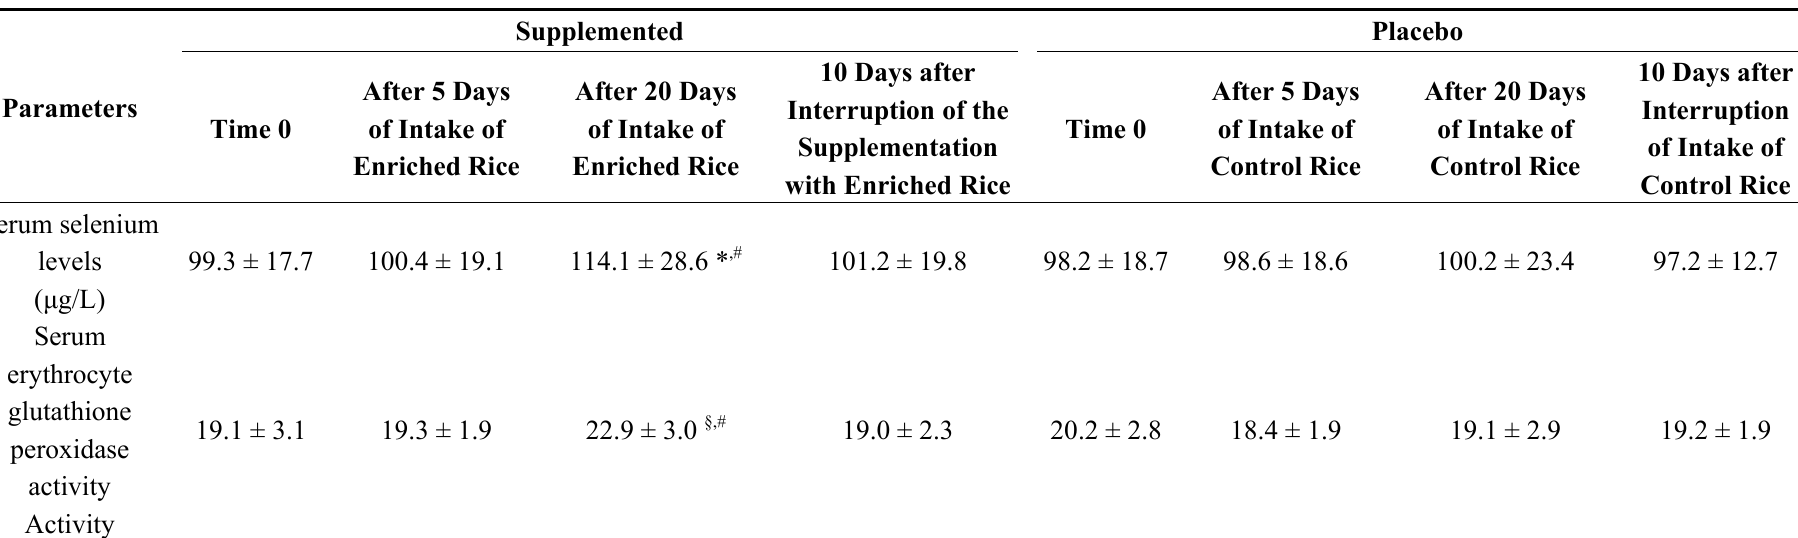
Table 1. Serum selenium levels and glutathione peroxidase (GPx) activity in basal conditions and after 5 and 20 days of intake of enriched rice or regular rice (placebo) and 10 days after interruption of supply. Values are means ±